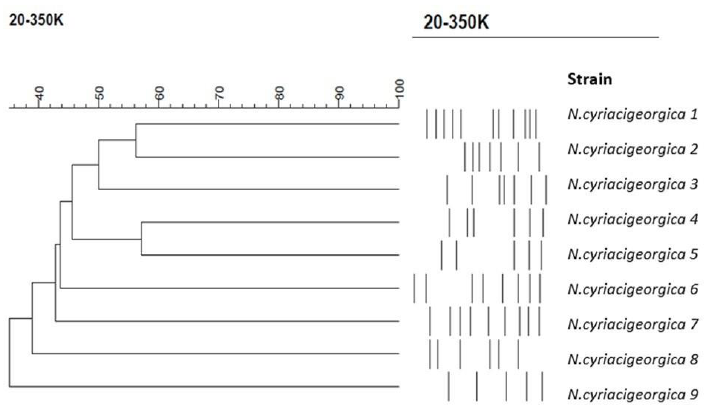
Figure 3. Genetic relationships of N. cyriacigeorgica by PFGE analysis. 2.6. Phylogenetic Tree by MLSA Scheme In our study, there were 12 Nocardia spp. The differences in four-locus ( gyrB -16S rRNA- secA1 - hsp65 ) MLSA concatenated sequences among these 12 species and the evolu- tionary phylogenetic trees are shown in Figure 4. The similarity between N. beijingensis and N. asiatica was as high as 99%, and that between the two species and N. farcinica was 77%. N. beijingensis and N. asiatica belonged to the N. abscessus complex [7], and their nu- cleic acid similarity was up to 99%. N. niigatensis and N. crassostreae had a similarity of 73%. N. cerradoensis had an 86% similarity to N. cyriacigeorgica . Additionally, N. amikacinit- olerans was independent and had greater differences than the other species.